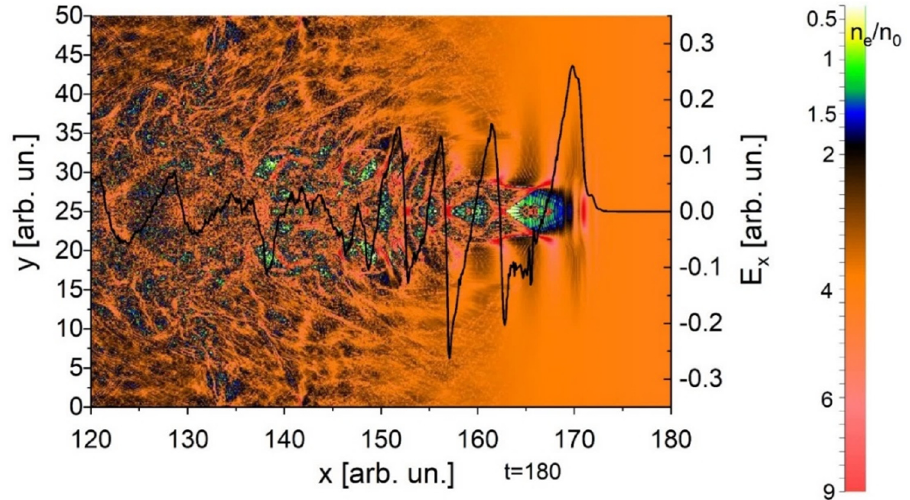
Figure 5. Excitation of a wakefield by a laser pulse in inhomogeneous plasma t = 180 T 0 . Plasma electron density distribution and longitudinal accelerating field. x, y are normalized to λ , E x is normalized to E 0 = m e c ω ℓ /2 π e .